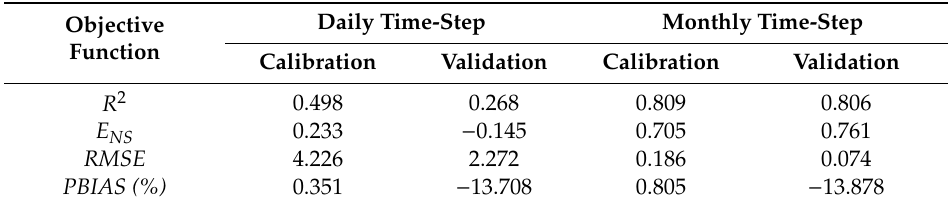
Table 6. Comparison of mean, standard deviation, minimum and maximum daily mean streamflow (m 3 /s) between measured and simulated values for the baseline model in the calibration (1998–2005) and validation (2006–2008) periods at the Kožbanjš č ek catchment main outflow.